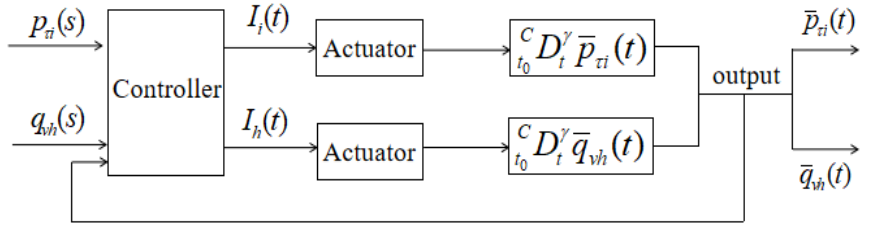
Figure 2. Control framework of linear feedback controller